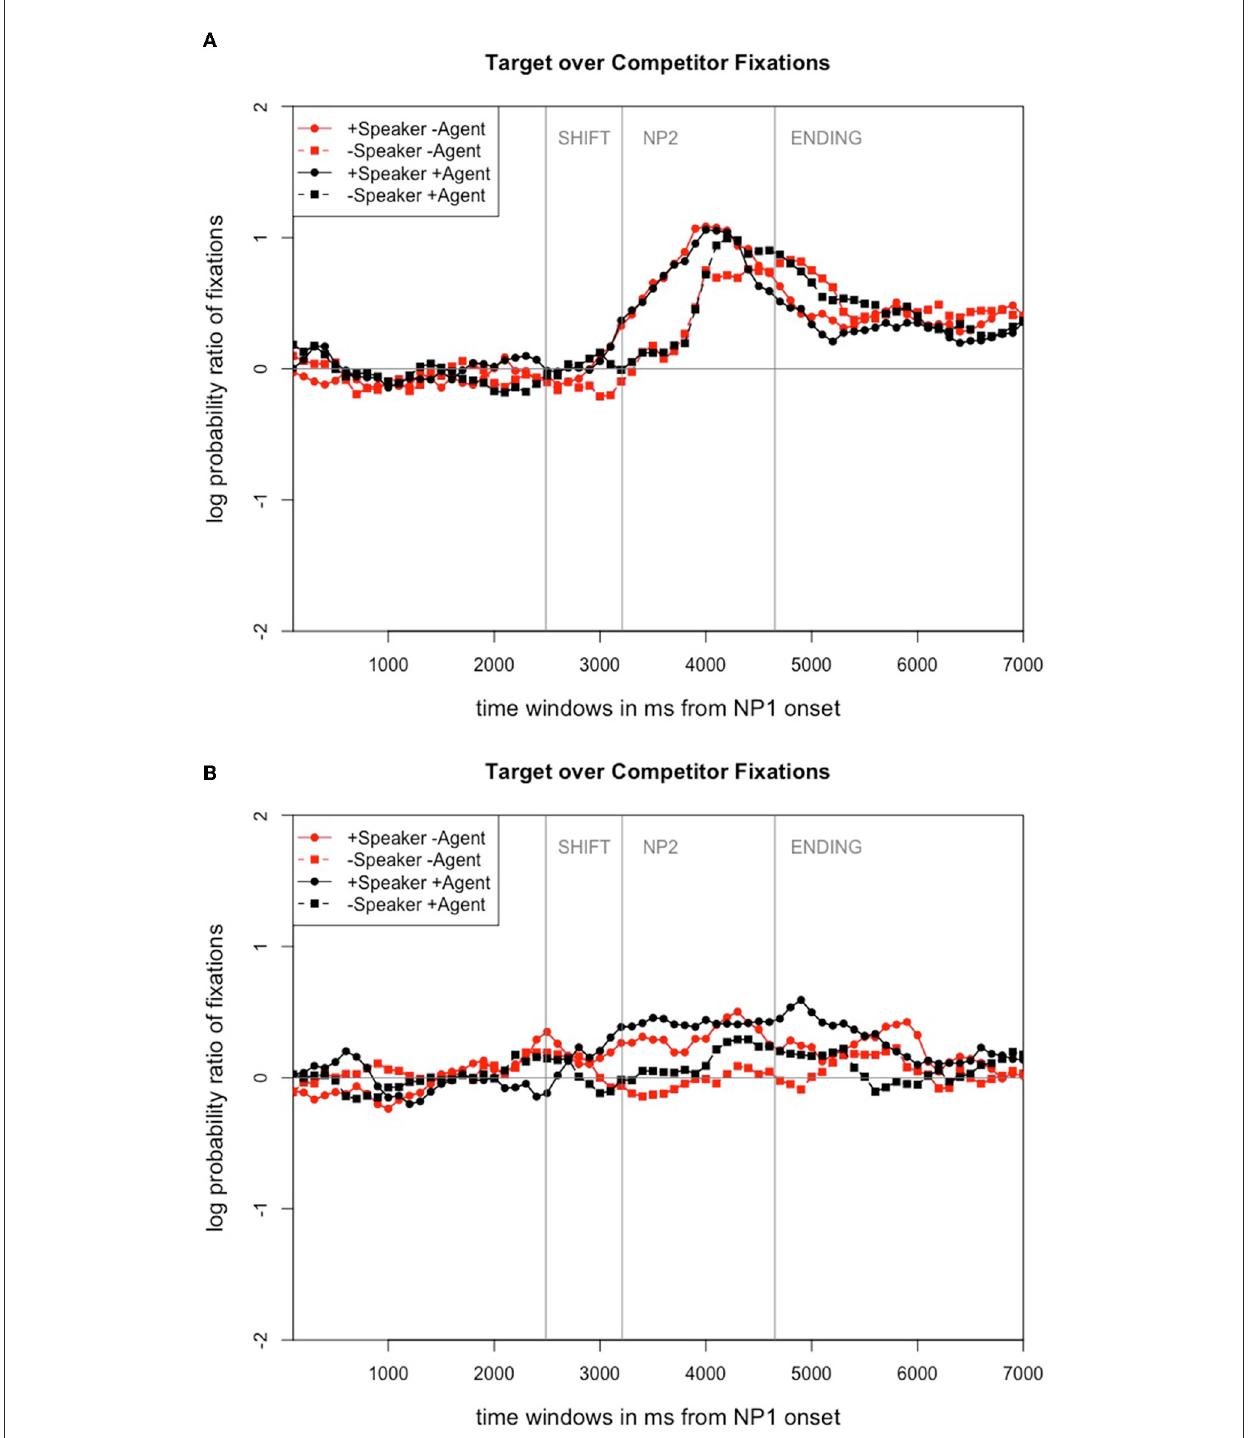
FIGURE4 Time course graphs (in ms ) from NP1 onset until ending offset. (A) Time course graph for Experiment 1. Adapted from Nunnemann (2021, p. 89). (B) Time course graph for Experiment 2. Adapted from Nunnemann (2021, p. 112).